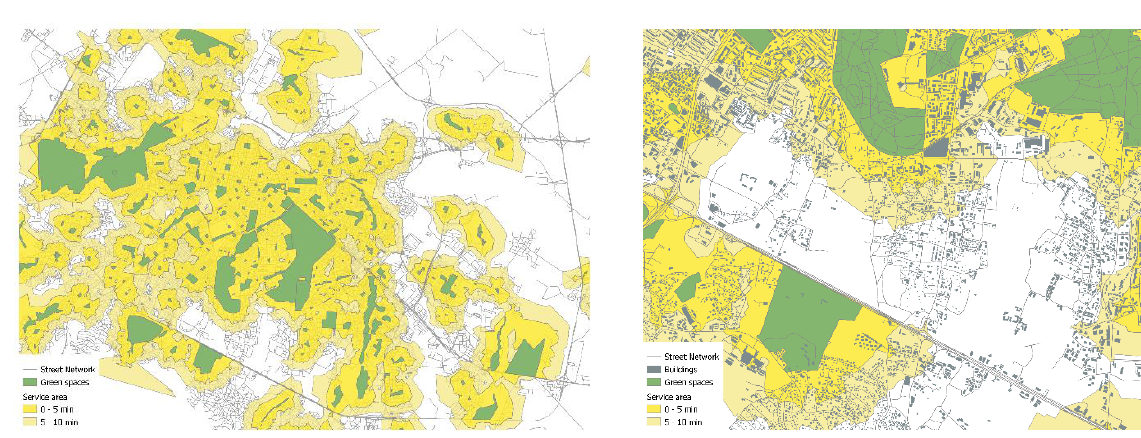
Figure 11. Network Analysis service area of parks.